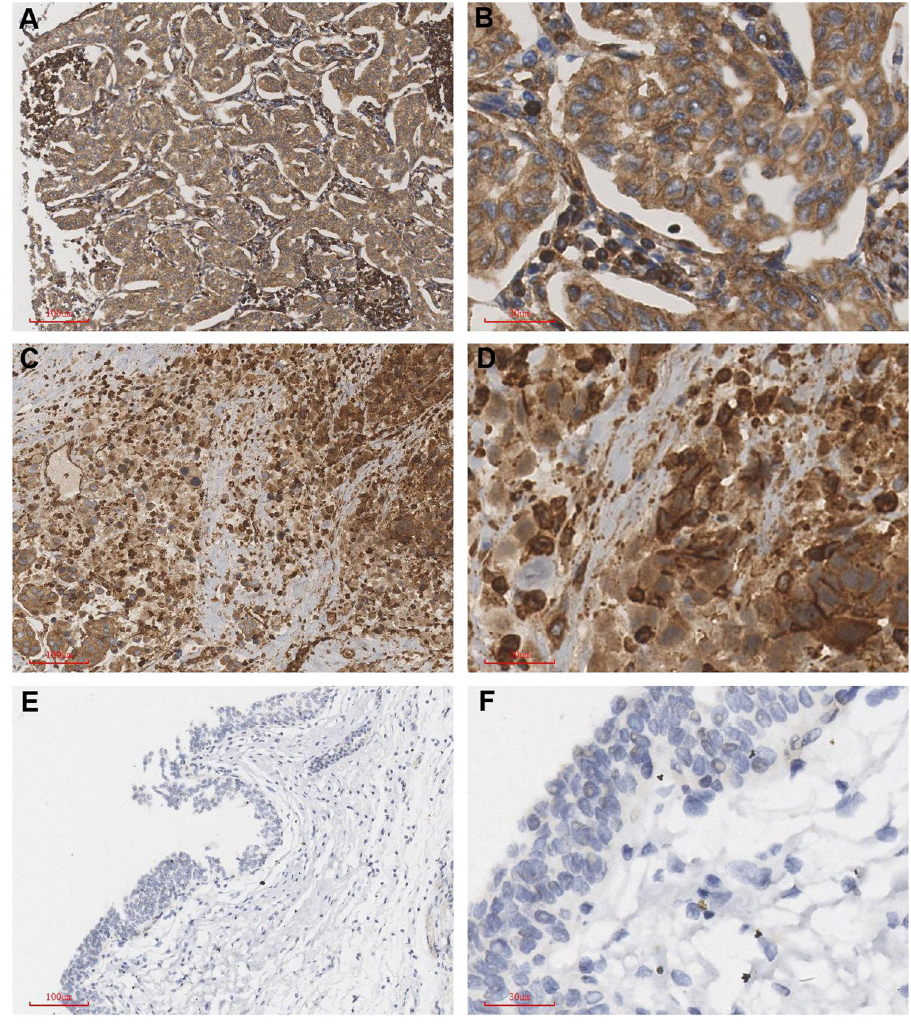
Figure 1. The expression of PLAGL2 in the positive lymph nodes of the bladder cancer was significantly higher than the expression in the primary BUC tissues. The expression of PLAGL2 in BUC tissues was significantly higher than the expression in normal tissue ( A , B ) Positive lymph nodes: ( C , D ) BUC; ( E , F ) Normal bladder tissue; ( A , C , E ), × 100; ( B , D , F ), ×